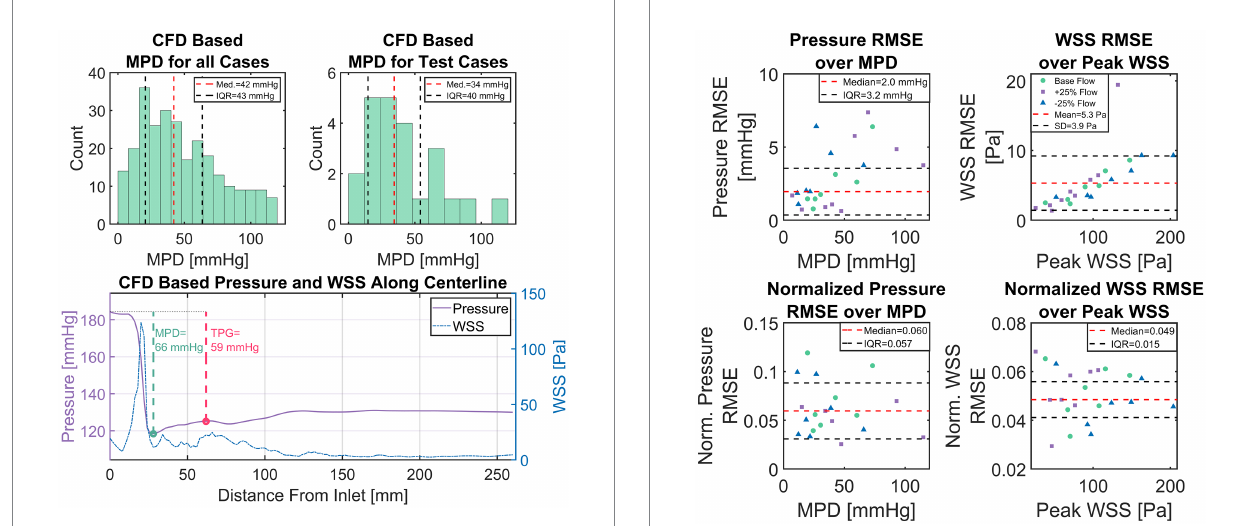
FIGURE 6 Top left: Distribution of maximum pressure drop (MPD) within the entire simulation data. Top right: Distribution of MPD within the set of test cases. Bottom: An exemplary depiction of CFD-based pressure and wall-shear-stress (WSS) in the compact representation (i.e., average along centerline). Additionally, the measurement points for transvalvular pressure gradient (TPG, red) and MPD (green) are shown with their respective values.